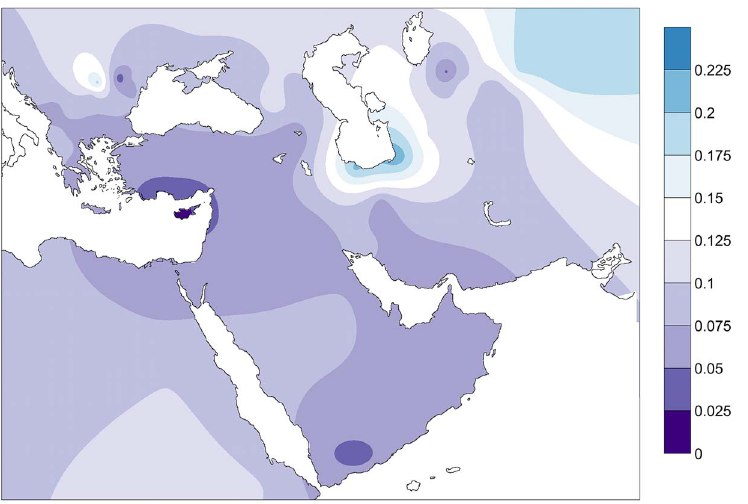
Figure 4. Contour map of Fst distances between the PPNB population and modern populations of the database. Only populations with clear geographic distribution were included. Gradients indicate genetic distance between the PPNB and the modern populations (dark: small; clear: high).